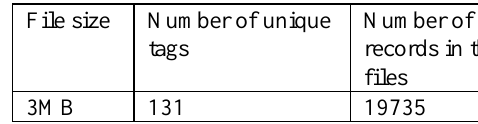
Table2. Brief description of the training dataset